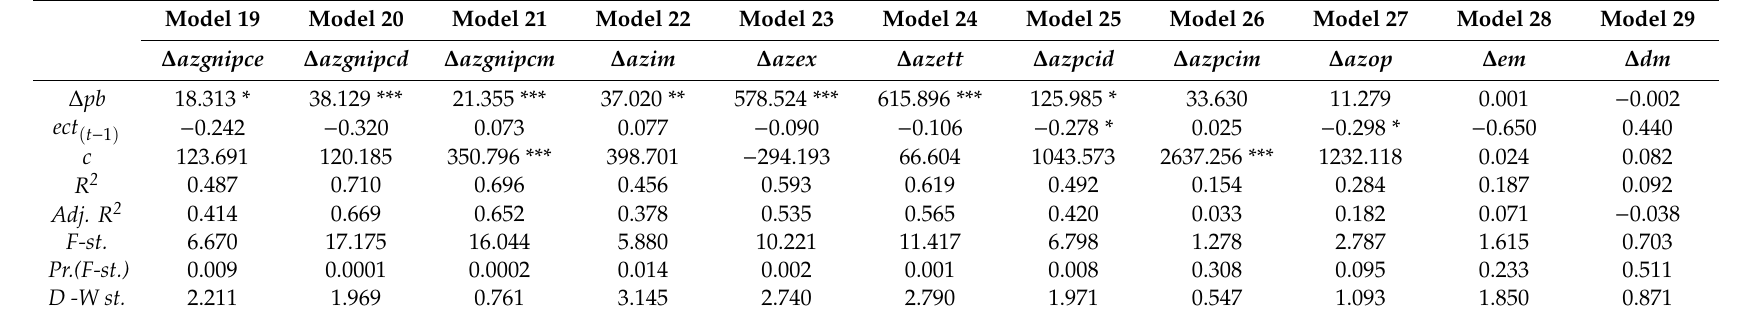
Table 4. The influence of oil price on macroeconomic indicators